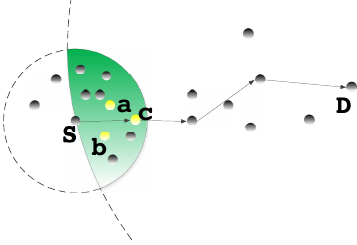
Figure 5. EM-GPSR greedy